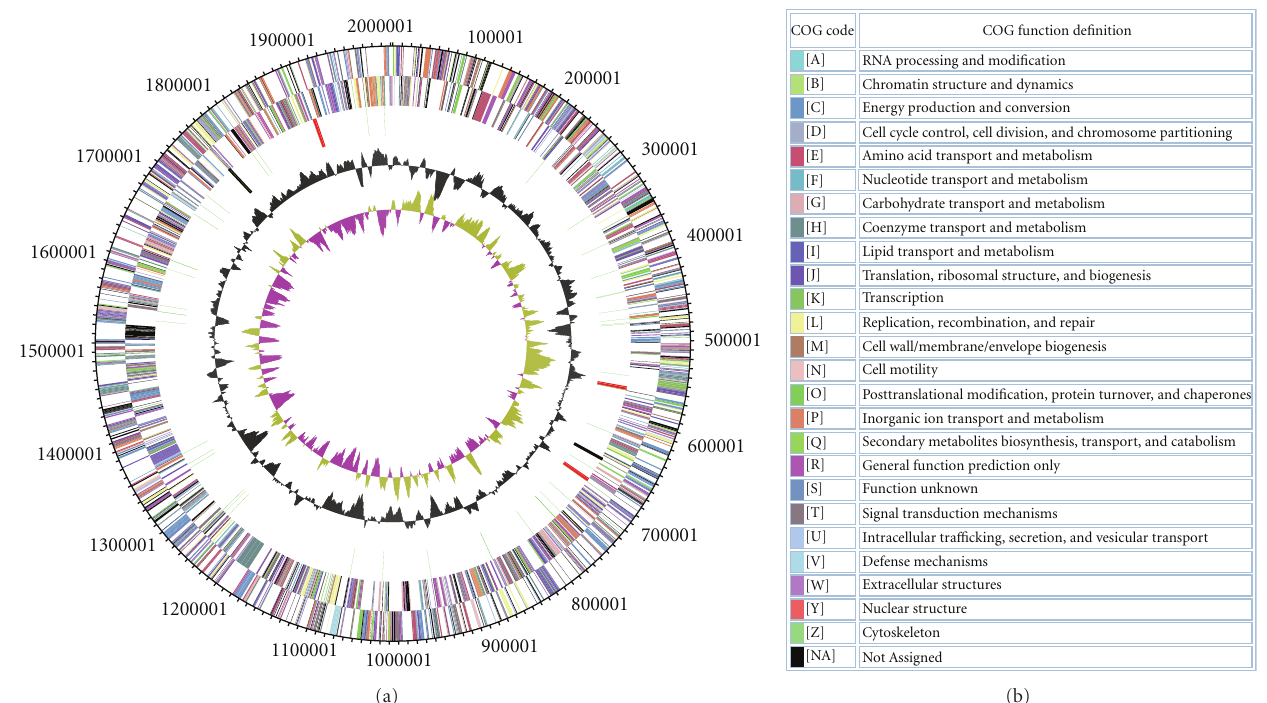
Figure 4: (a) Graphical circular map of the genome. From outside to the center: genes on forward strand (color by COG categories), genes on reverse strand (color by COG categories), RNA genes (tRNAs green, rRNAs red, and other RNAs black), GC content, GC skew. (b) Color code for COG